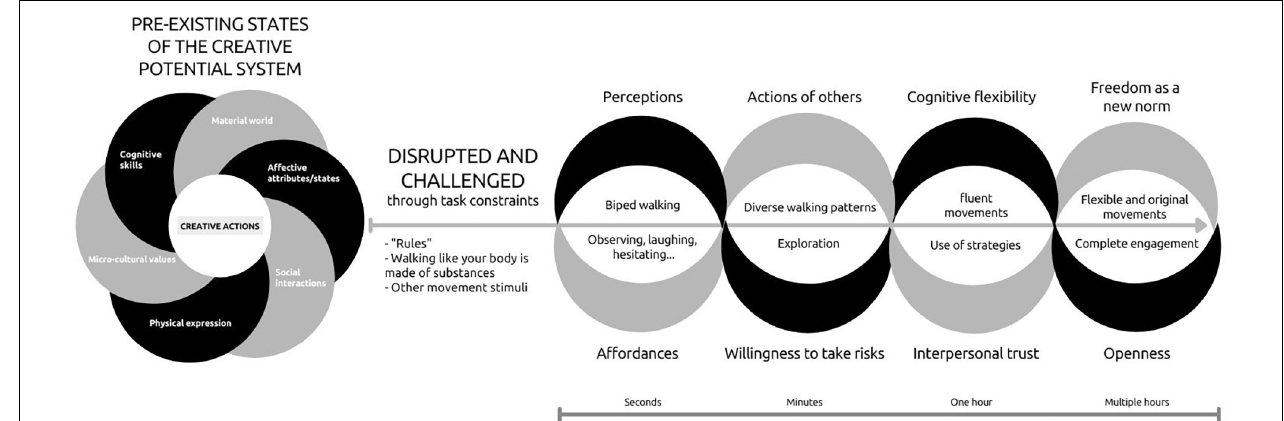
FIGURE 2 | An example of a movement improvisation session mechanisms of change. The left intertwined strands image (i.e., summary of Figure 1 ) represents the pre-existing state of the creative potential system. Once the system is disrupted and challenged by a movement improvisation activity, the right part of the Figure presents the untied individual and environmental strands. We untied the strands to illustrate how the individual elements (black strand) and environmental elements (gray strand), while still interacting, hypothetically change on a time scale from a few seconds to a few hours. The mid-line arrow illustrates the direction of the chronology of these changes. Also, the white space above the mid-line arrow shows the emerging observable motor behaviors while the white space below the arrow presents other behaviors expressed throughout the